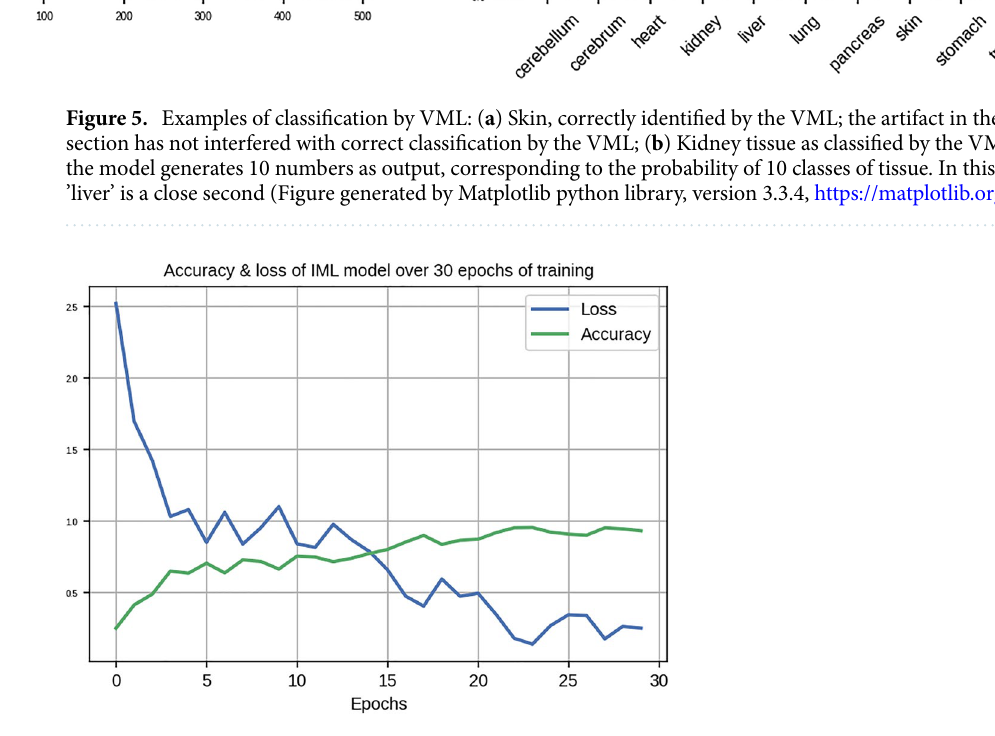
Figure 6. Accuracy and loss over 30 epochs of training the Inception model; this model showed a much sharper drop in error rate (loss) during the early epochs, than the VML model (Fig. 4) (Figure generated by Matplotlib python library, version 3.3.4, https:// matpl otlib.